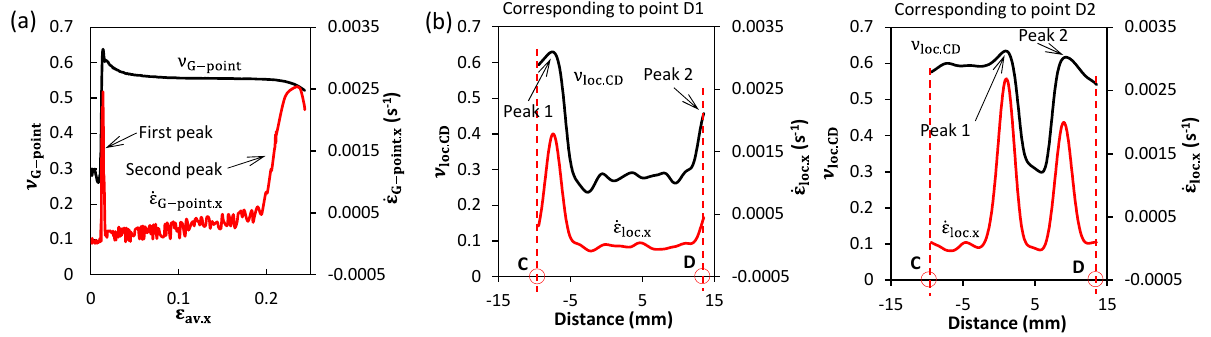
Figure 10. Correlation of the Poisson’s ratio with the strain rate. ( a ) The evolution of the local Poisson’s ratio ( ν G − point ) and the longitudinal strain rate ( ε . G − point.x ) at point G in the tension process. ( b ) The distributions of the local Poisson’s ratio ( ν loc.CD ) and the longitudinal local strain rate ( ε . loc.x ) along the CD line at two stress points (D1 and D2) are shown in Figure